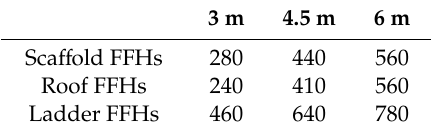
Table 7. Lead times (ms) according to di ff erent motions in the dynamics